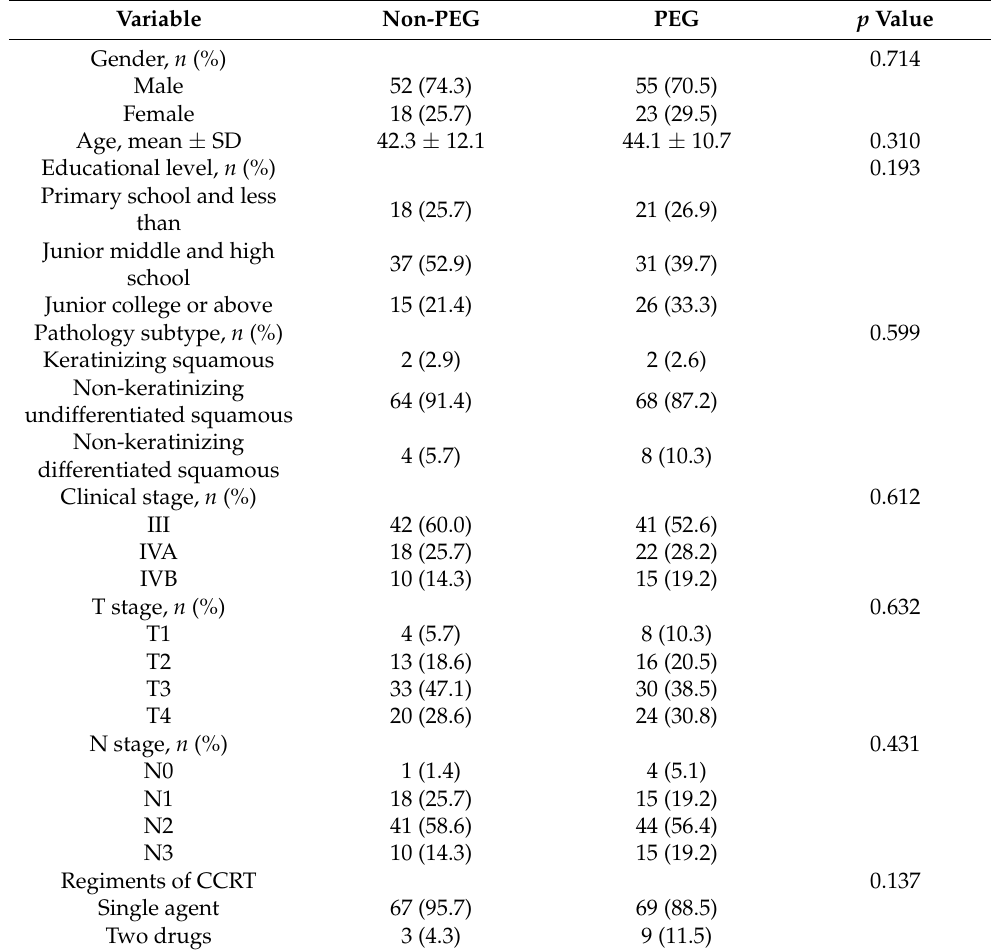
Table 1. Baseline characteristics of the study